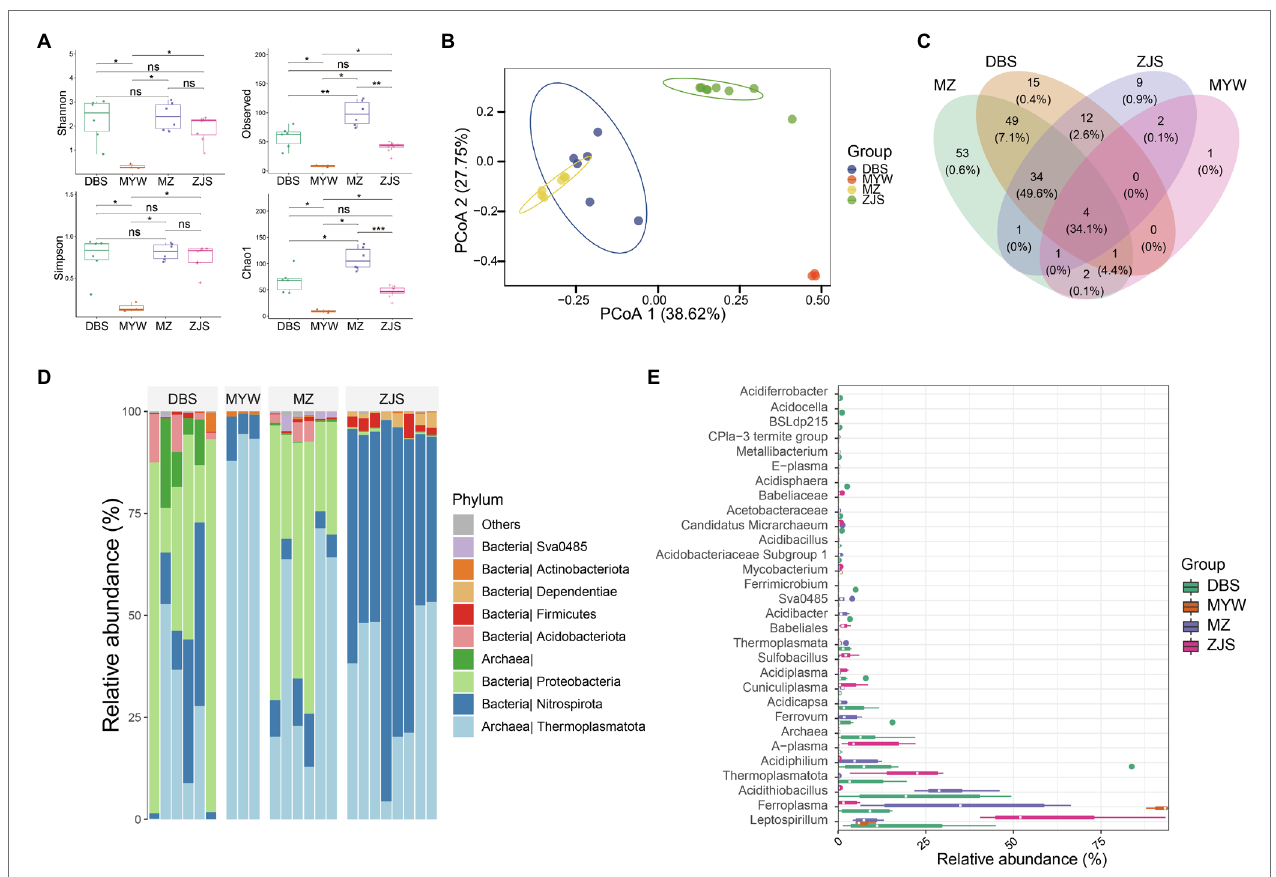
FIGURE 2 | Dissimilarities of AMD microbial communities of four mining areas. (A) Alpha-diversity of AMD shown by the Shannon diversity index. (B) Principal coordinates analysis based on Bray–Curtis distance between samples. (C) Venn analysis of zero-radius operational taxonomic units (zOTUs) detected in four AMDs. (D) Relative abundance of microorganisms detected in AMD samples at the phylum level. (E) Top 50 taxa, at the genus level, in four AMD microbial communities. * p < 0.05, ** p < 0.01, *** p <